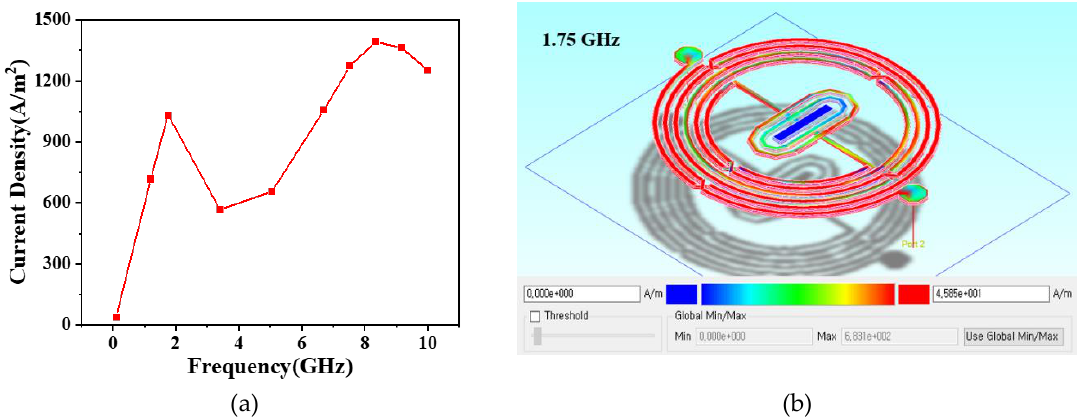
Figure 4. Simulated current density. ( a ) Frequency–current density illustration, and ( b ) Effects of 1.75 GHz on the simulated current density throughout the proposed BPF.